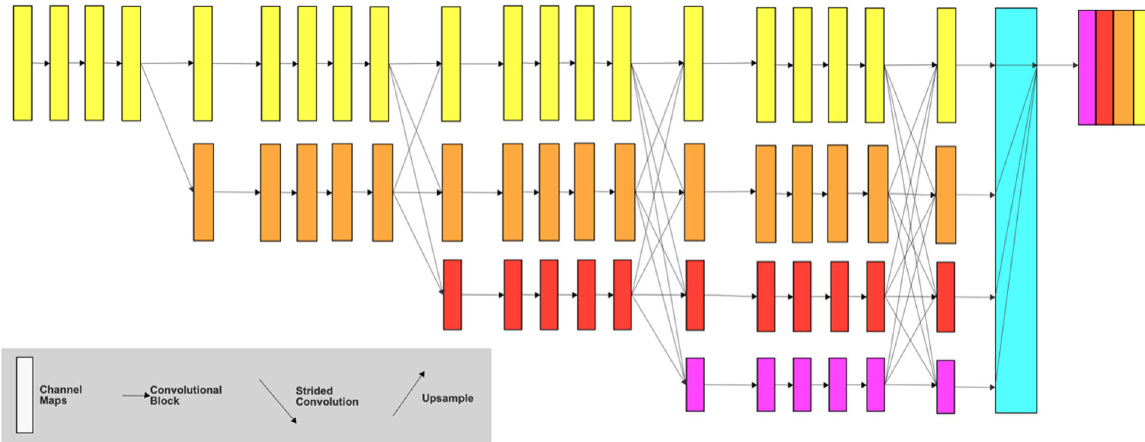
Fig. 18 High resolution net V2 model architecture. Schematic of the base model of the HRNetV2 architecture utilized